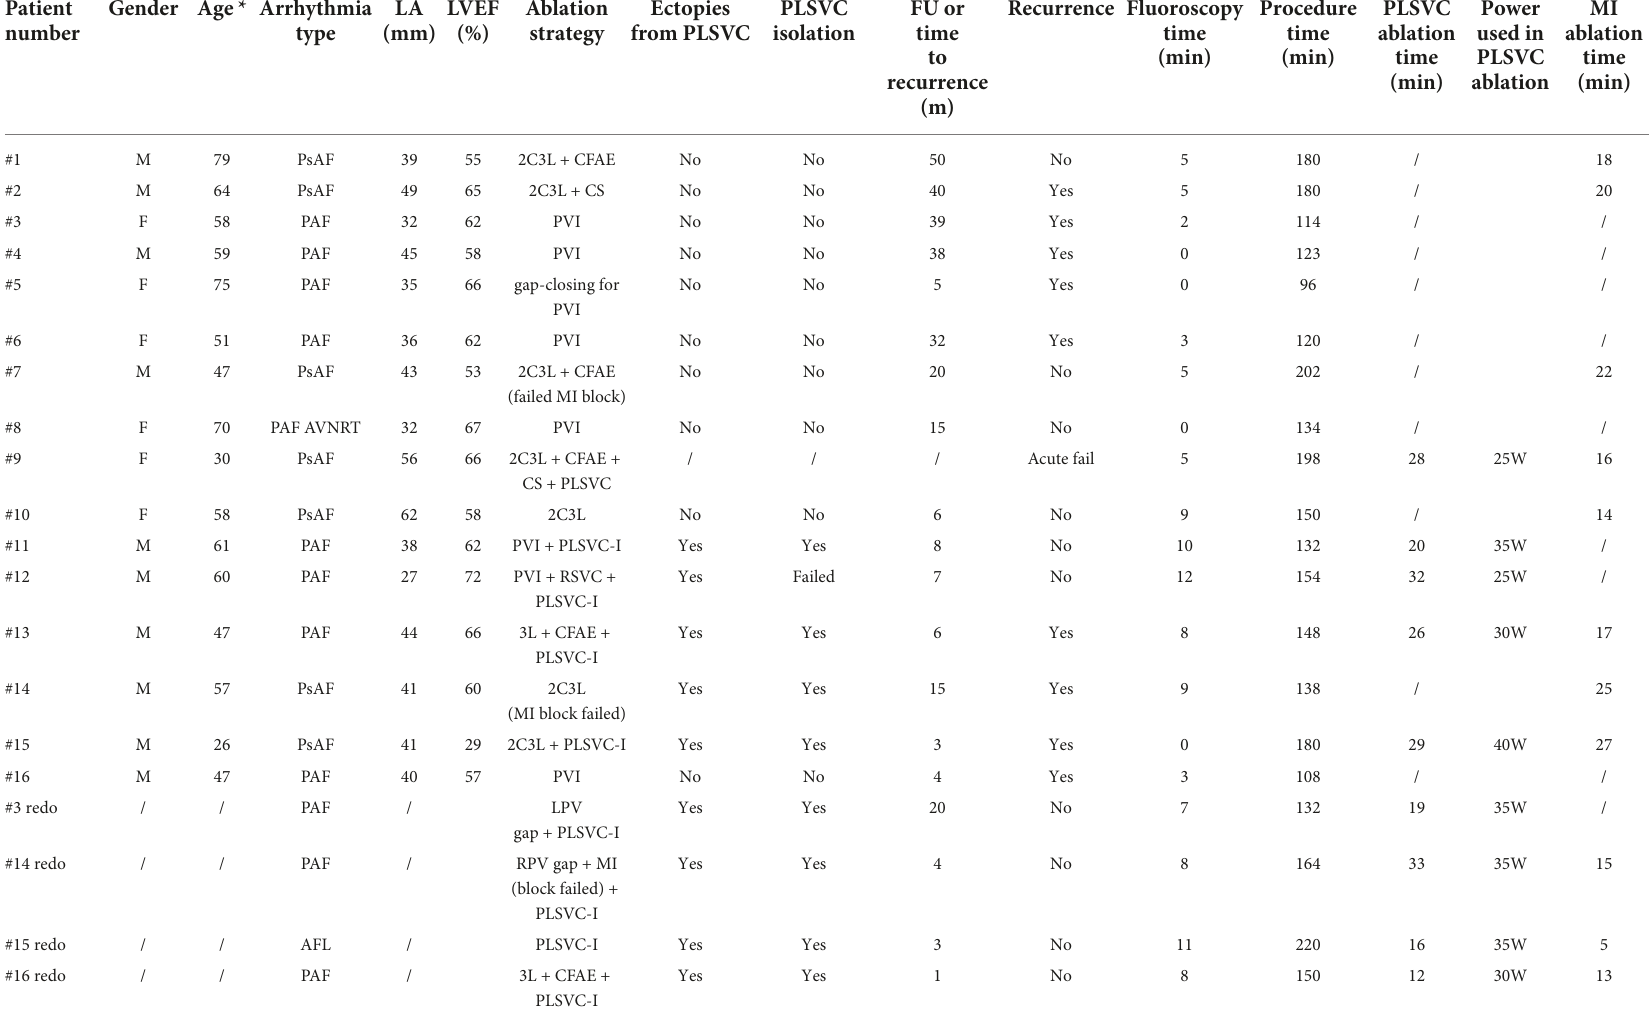
TABLE 1 Baseline and procedural